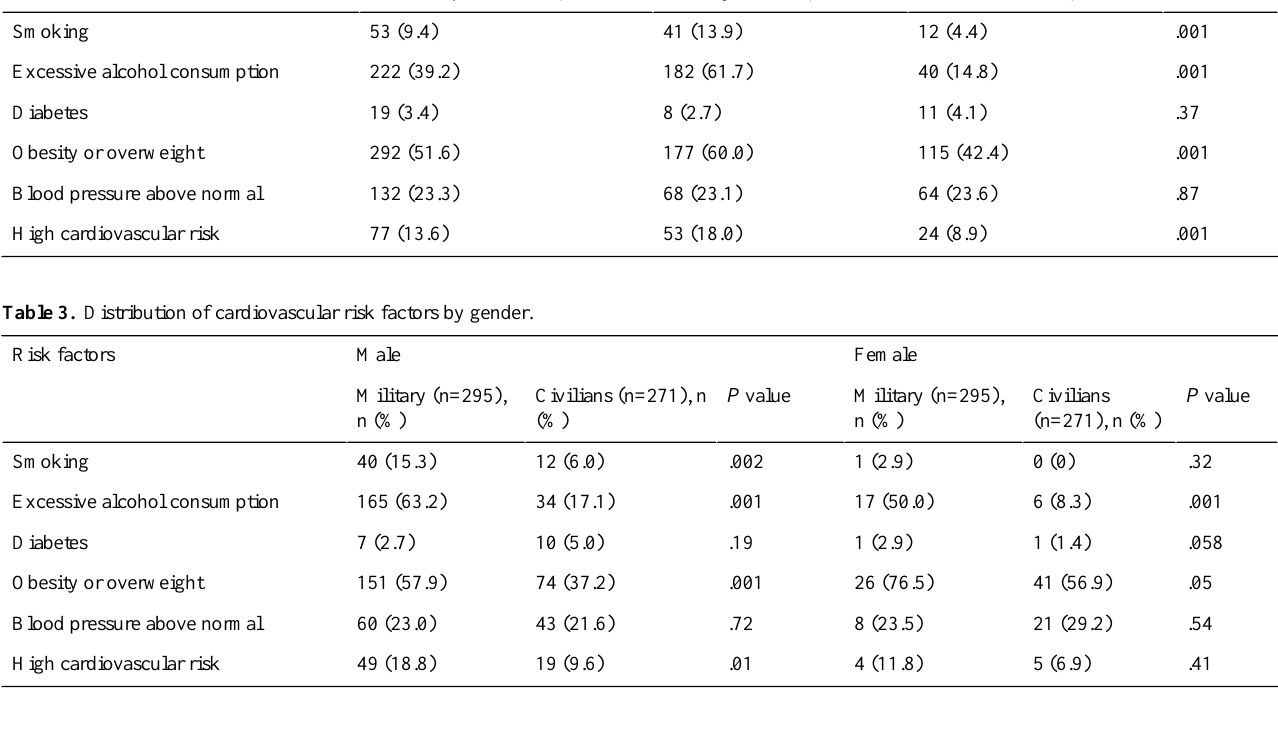
Table 4. Multivariate analysis of the relationship between high cardiovascular risk, occupation, age, and gender.